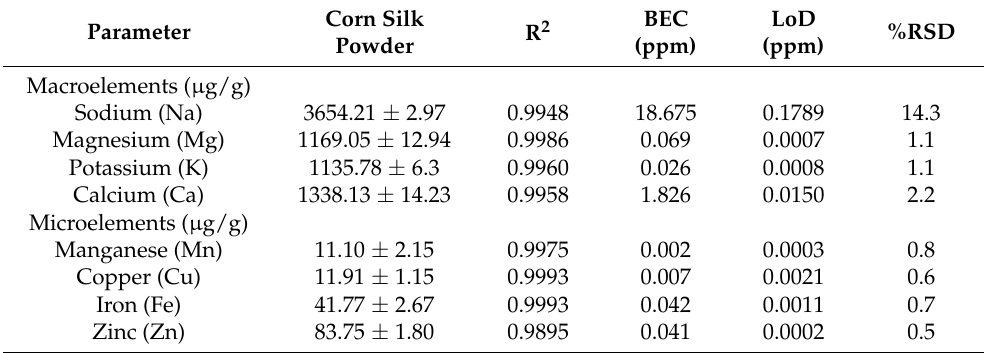
Table 2. Mineral analysis of corn silk powder using ICP-OES.